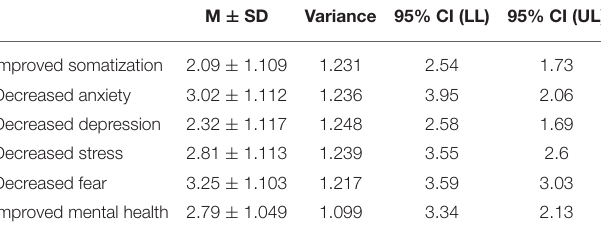
TABLE 4 | The positive influence of physical exercise on mental status. M ± SD Variance 95% CI (LL) 95% CI (UL) Improved somatization 2.09 ± 1.109 1.231 Decreased